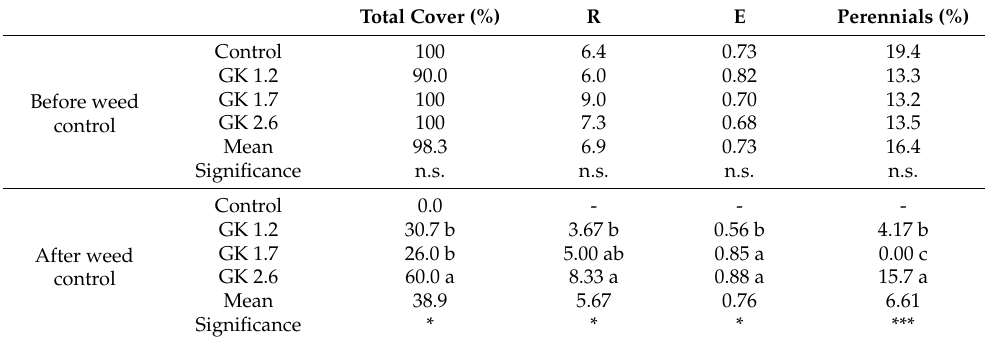
Table 2. Weed community structure before and immediately after the tested weed control